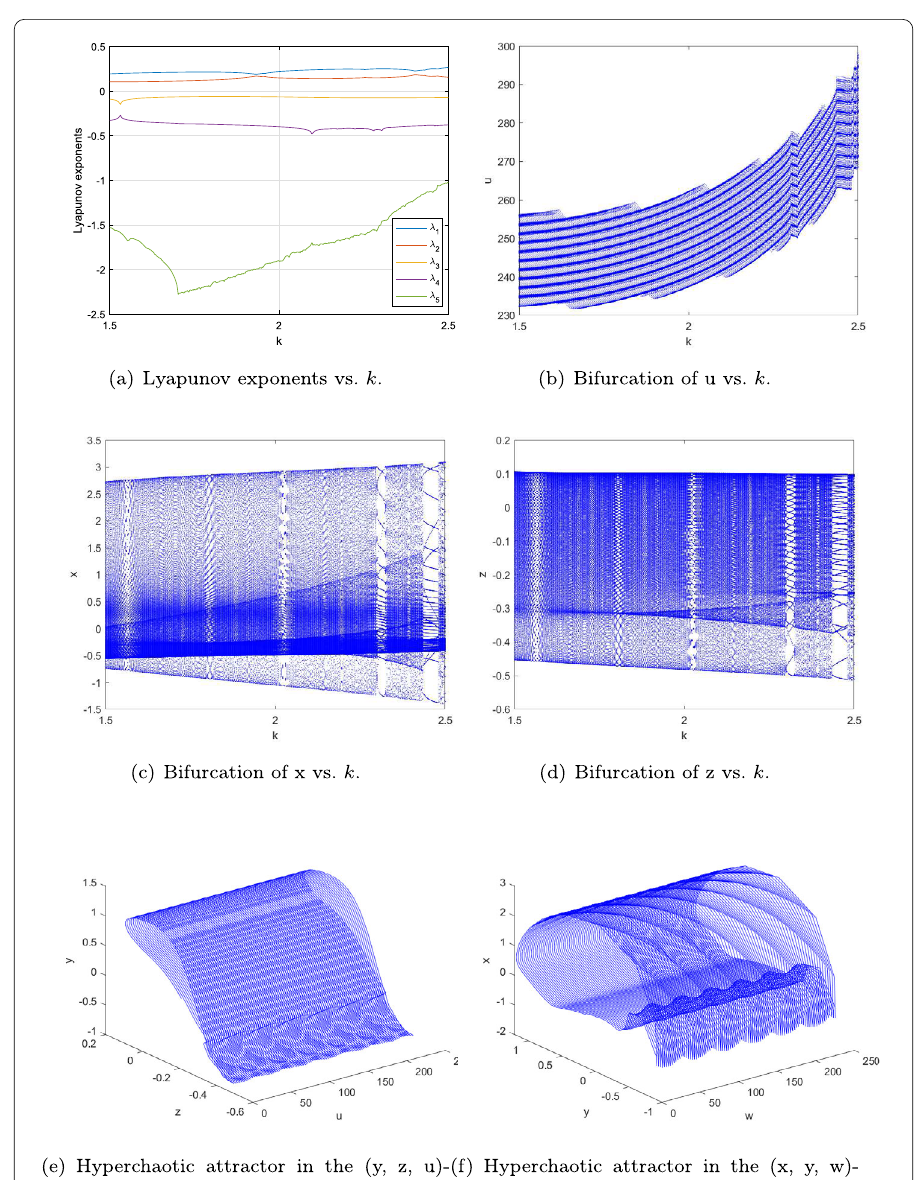
Figure 6 Complex behavior of system (16) with